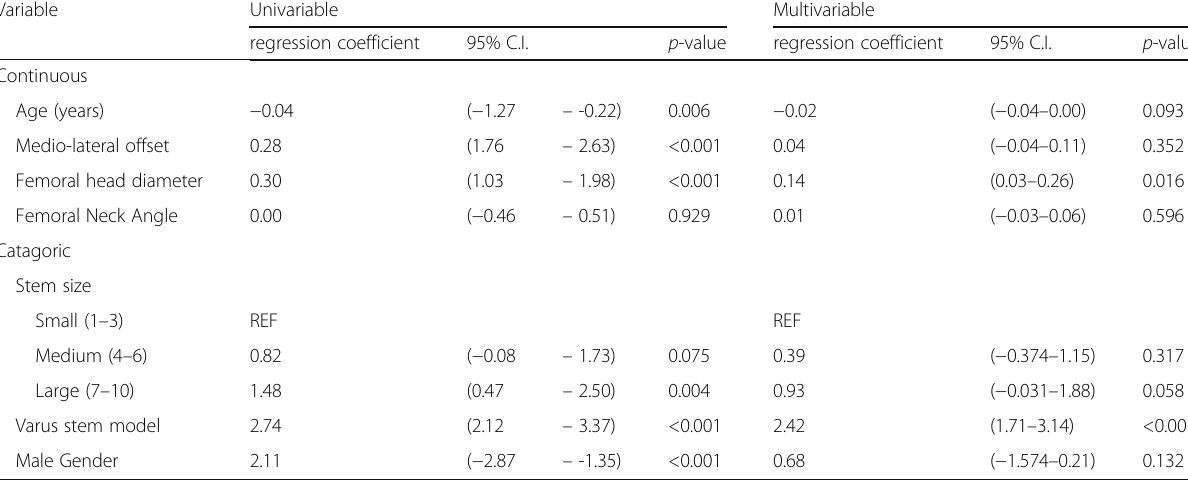
Table 2 Linear regression analysis of variables associated with Cortical Distance Variable Univariable Multivariable regression coefficient 95% C.I. p -value regression coefficient 95% C.I. p -value